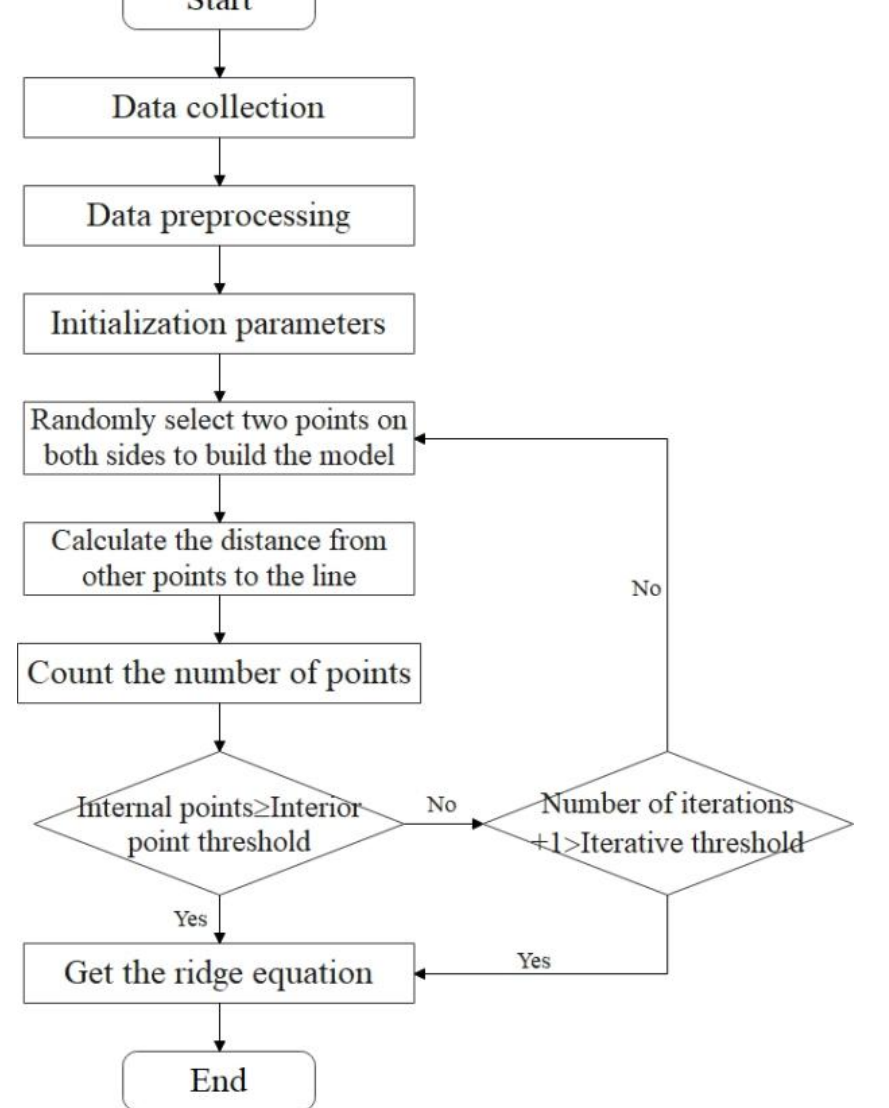
Figure 4. Flow chart of ridgeline extraction based on RANSAC.